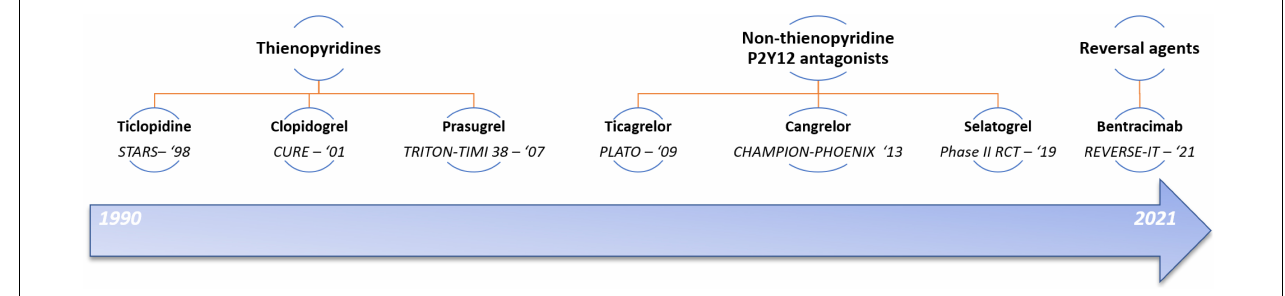
FIGURE 1 | Temporal developments of P2Y 12 receptor antagonists and associated landmark trials. Trials: STARS (12); CURE (5); TRITON-TIMI 38 (26); PLATO (25); CHAMPION-PHOENIX (112); Selatogrel—Storey et al. (109); REVERSE-IT